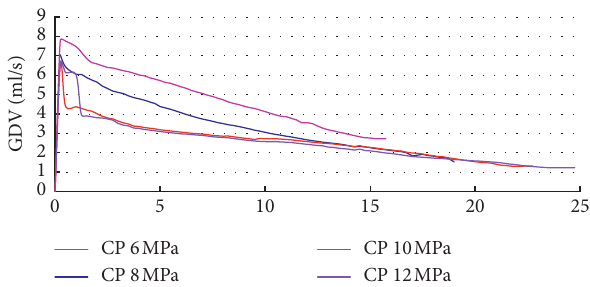
Figure 3: Gas desorption velocity curves under different confining pressure conditions.